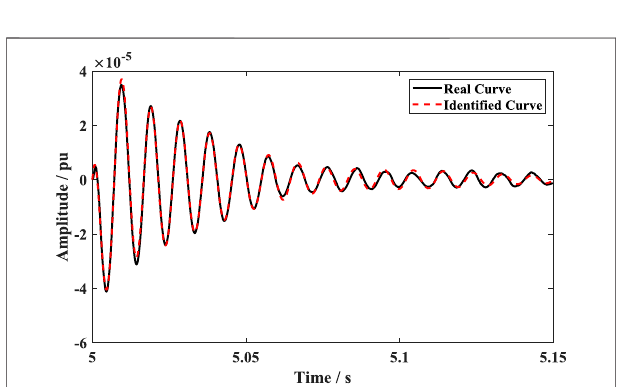
FIGURE 13 | Controllers K Q_system (s) with and without